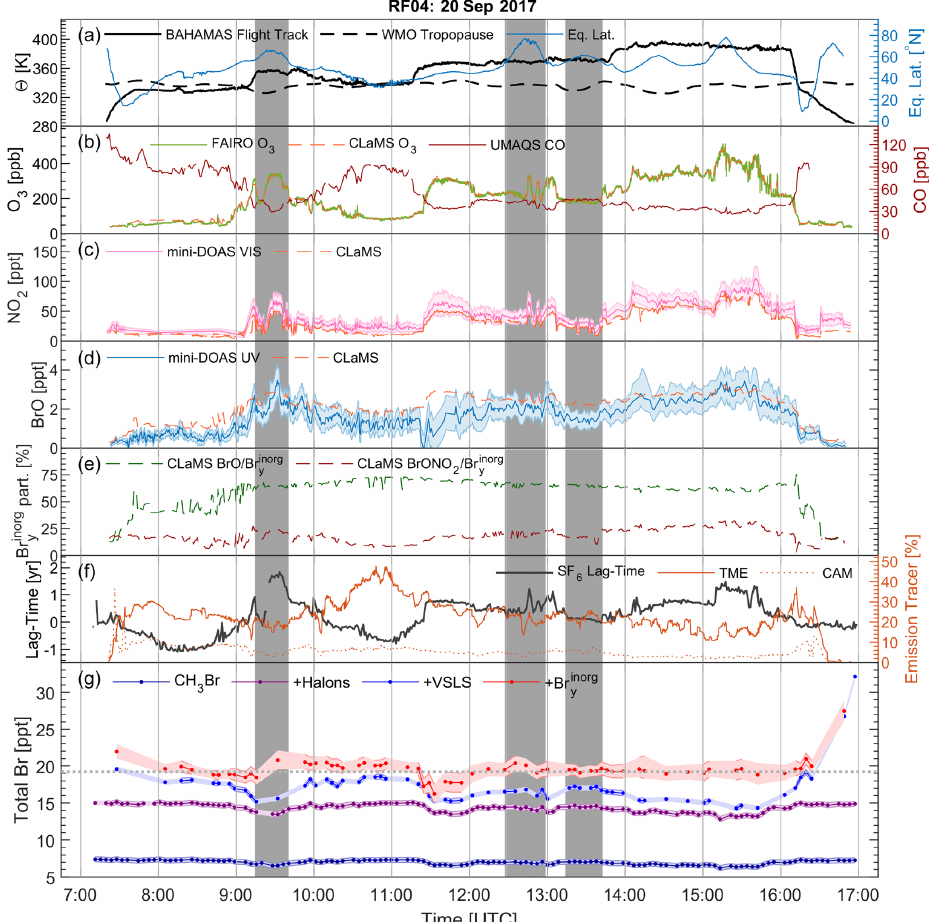
Figure 2. Overview of HALO RF04 on 20 September 2017 (dashed blue flight track in Fig. 1). The potential temperature of the flight trajectory and WMO TP (solid and dashed black lines, respectively) and equivalent latitude (solid blue line, right axis) are shown in (a) . The following panels show (b) FAIRO-measured (solid green) and vertically adjusted CLaMS-modeled (dashed orange) O 3 VMR as well as the UMAQS-measured CO (dark red line, right axis); (c) mini-DOAS-measured (solid pink) and vertically adjusted CLaMS-modeled (dashed orange) NO 2 VMR; (d) mini-DOAS-measured (solid blue) and vertically adjusted CLaMS-modeled (dashed orange) BrO VMR; (e) vertically adjusted CLaMS-simulated ratios of BrO / Br inorg y (dashed green) and BrONO 2 / Br inorg y (dashed dark red); (f) the mean lag time of air inferred from GhOST’s SF 6 measurements (solid black line) as well as the CLaMS emission tracers from the TME (tropical marine environment) in southeastern Asia and the CAM (Central America) region (solid and dotted orange line, respectively on the right axis); and (g) GhOST-measured CH 3 Br (blue), to which the VMRs of the halons (purple), brominated VSLS (light blue), and inferred Br inorg y (red) are subsequently added. The gray dotted line in (g) represents the campaign LS weighted average of [Br tot ] = 19 . 2 ± 1 . 2ppt. Dark gray shading indicates flight sections in the high bromine region (HBrR) between eq. latitudes 55 − 80 ◦ N and (cid:50) = 350–385K, as discussed in the text.